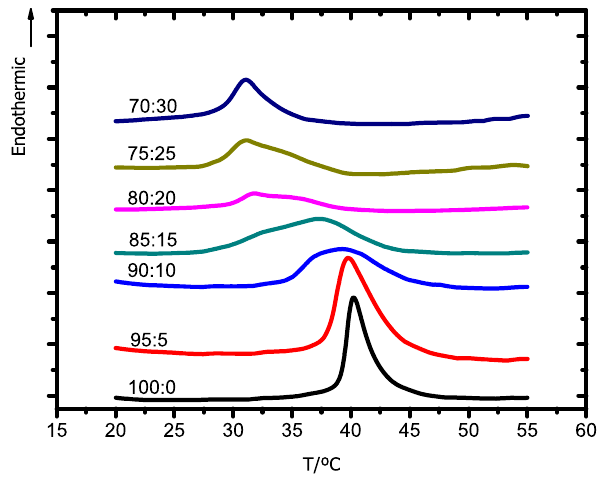
Figure 5. DSC thermograms of the DPPC:Chol:12-2-12 system for the lipid:surfactant molar ratios indicated. A scanning rate of